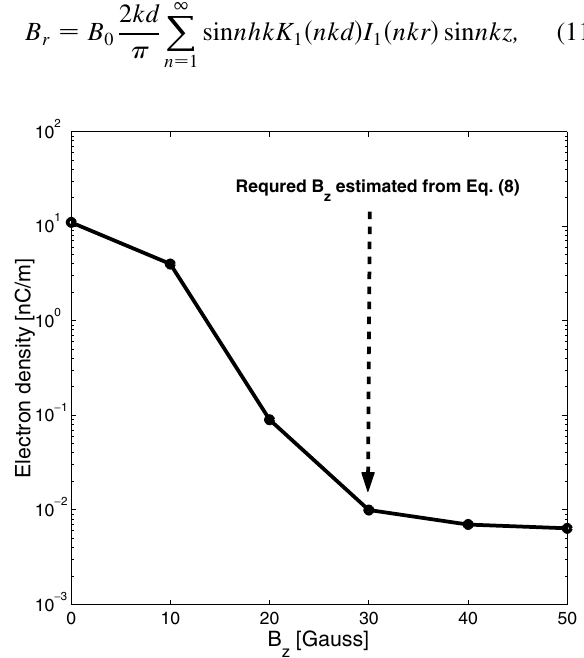
FIG. 13. Reduction of electron line density with increasing uniform solenoid fields. The dashed line indicates the required field estimated from Eq. (8) with ’ of 20 mm and energy 300 eV.